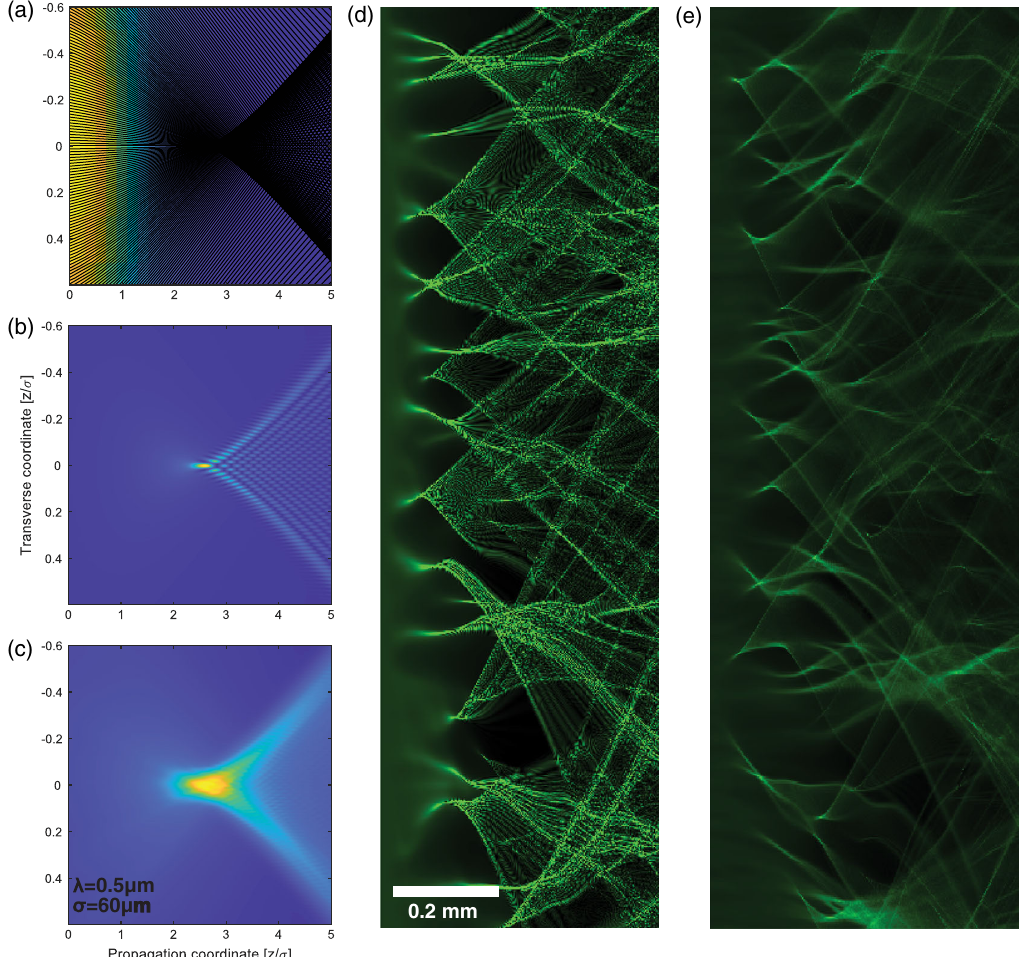
FIG, 4. (a) – (c) Intensity patterns produced by a single scatterer in (a) ray optics simulation and (b),(c) wave propagation simulations of an incident coherent and partially-spatially-incoherent beam in the paraxial approximation, respectively. (a) shows the ray structure of the scattered light forming caustics. (b) shows the main caustic lobes accompanied by weaker sidelobes and interference pattern. (c) shows two branches with no sidelobes and interference pattern. The main lobes are common to all three cases. (d),(e) Simulation of coherent and incoherent BF in a specific realization of refractive index landscape reconstructed from the